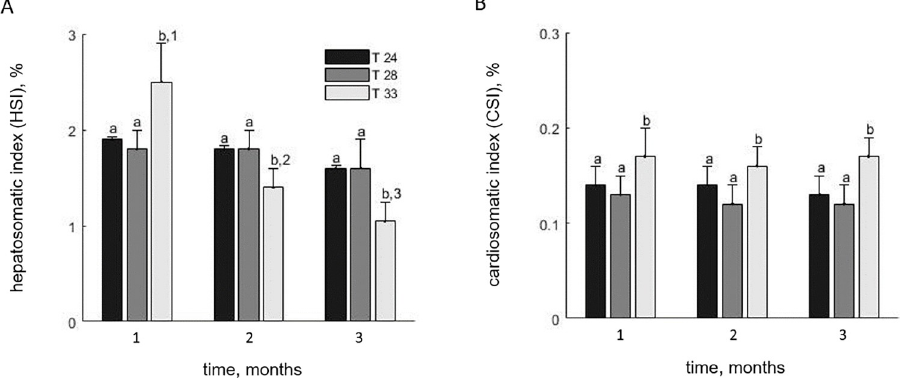
Fig 2. Hepatosomatic (A) and cardiosomatic (B) index for E. sea bass reared under three temperatures (T-24, T-28, T- 33). Points denote mean values between replicates and bars the standard deviation (3 replicates, N = 5 per replicate).